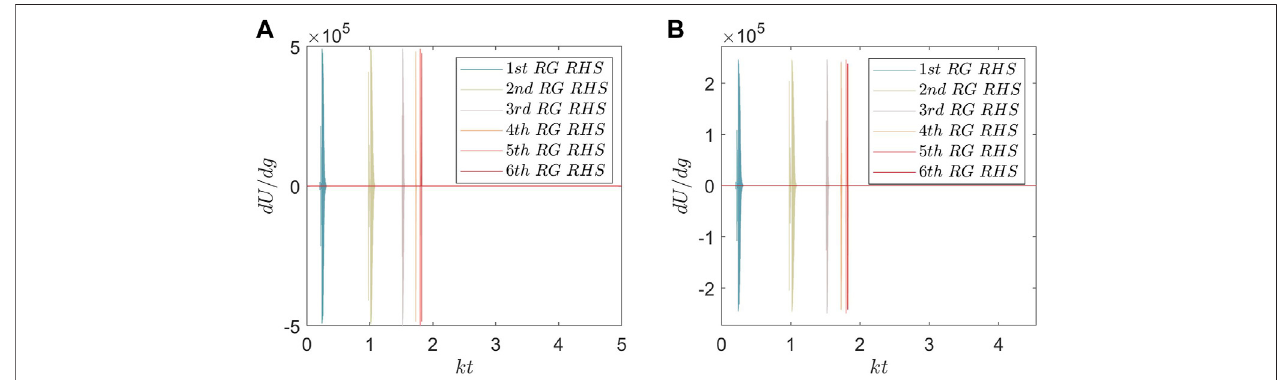
FIGURE 6 | First derivative of the uncertainty equality (A) and inequality (B) versus kt with the increasing number of QRG iterations.